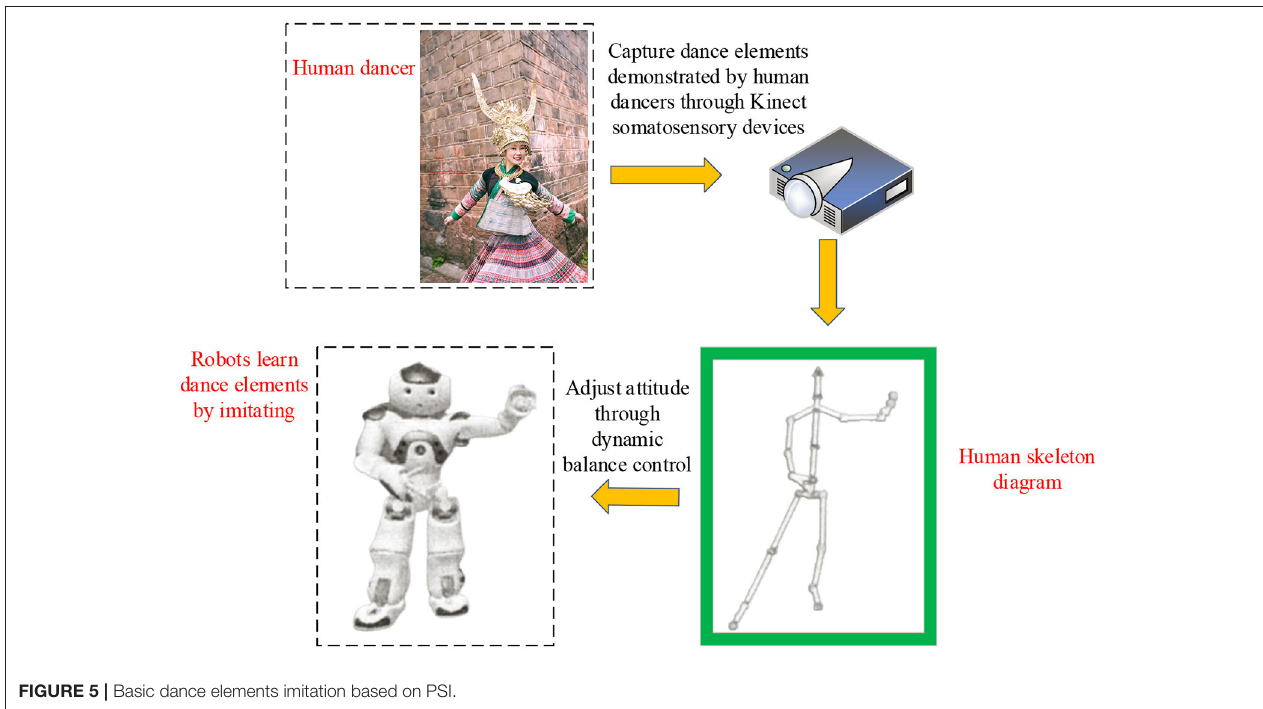
FIGURE 5 | Basic dance elements imitation based on PSI.